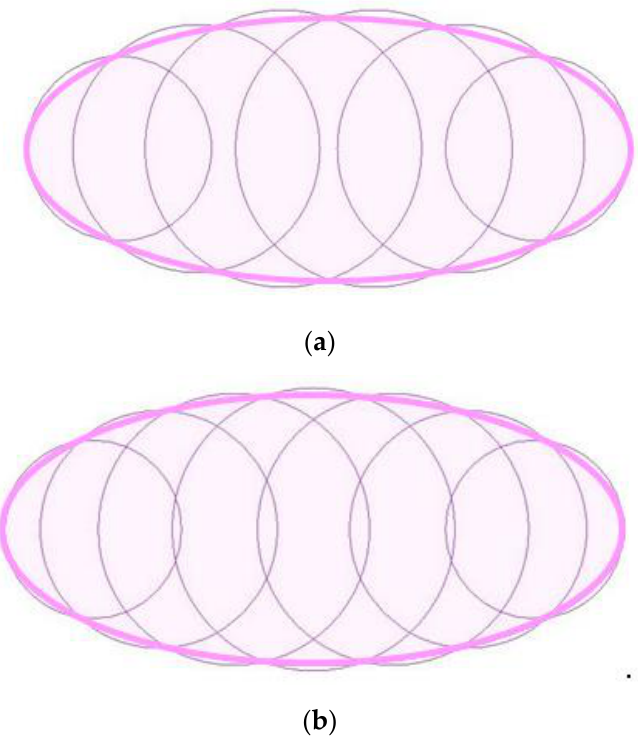
* 6 M  * 7 M  circles; ( b ) by circles.